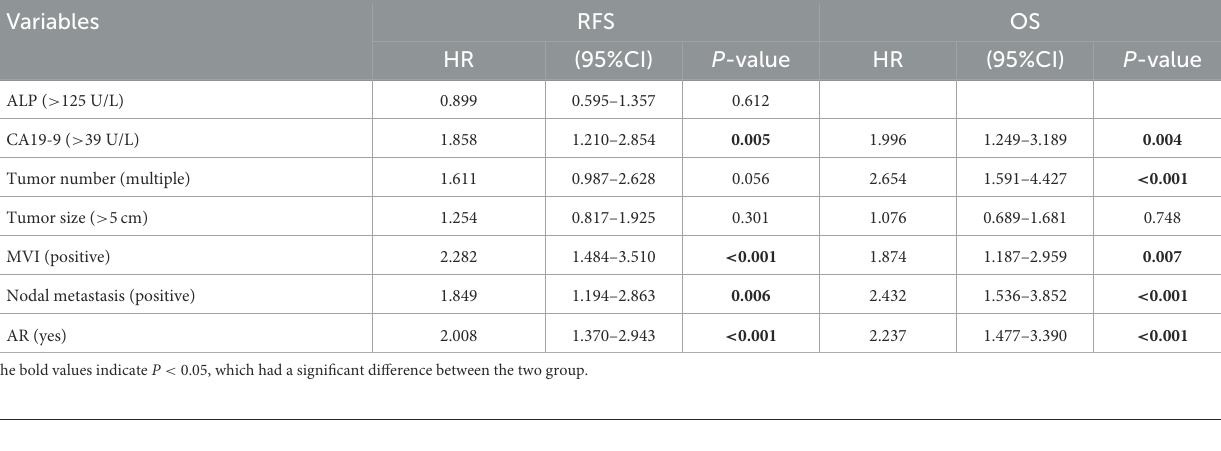
TABLE 2 Multivariate analysis of factors related to the RFS and OS before PSM.